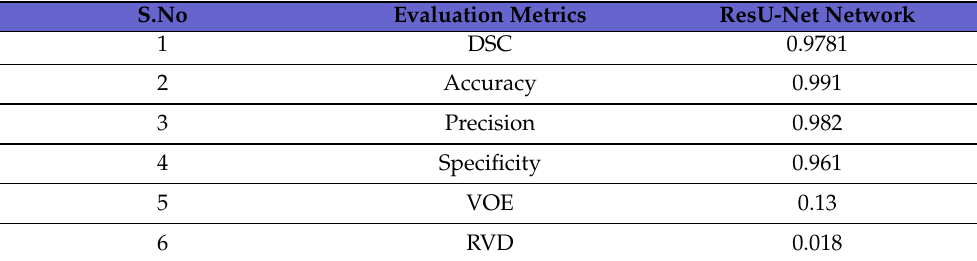
Table 2. ResU-Net model results on liver segmentation.